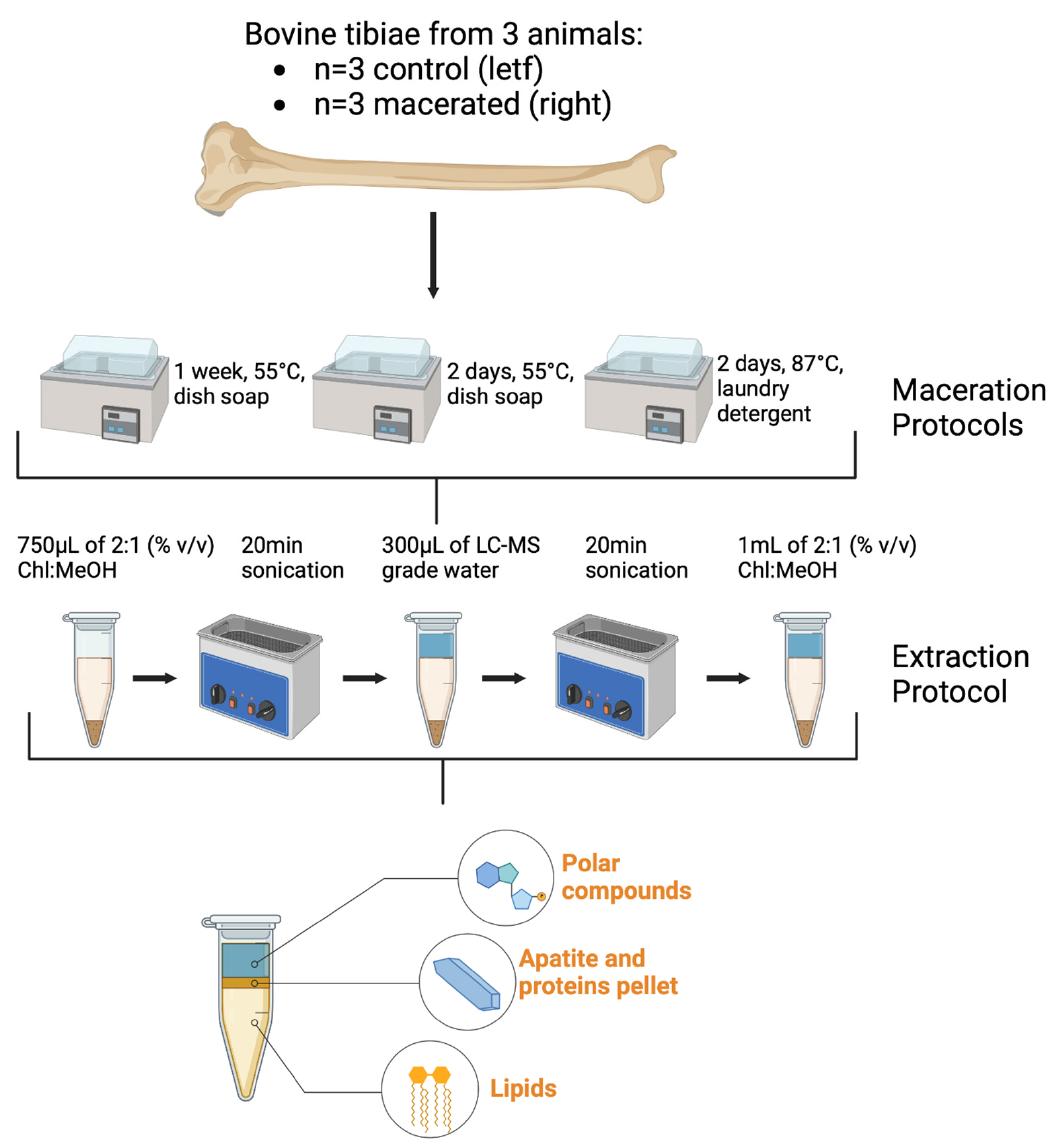
Figure 1. Schematic representation of maceration protocols and compound extraction.